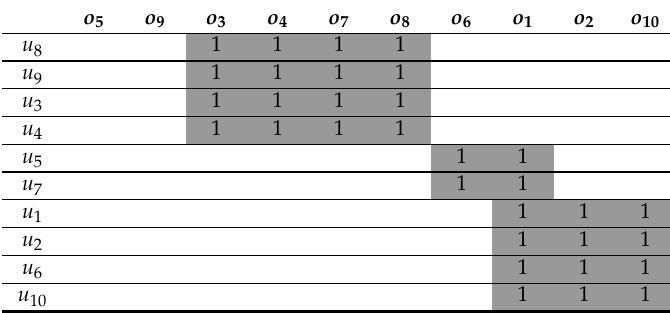
Table 6. Rearranged matrix A op